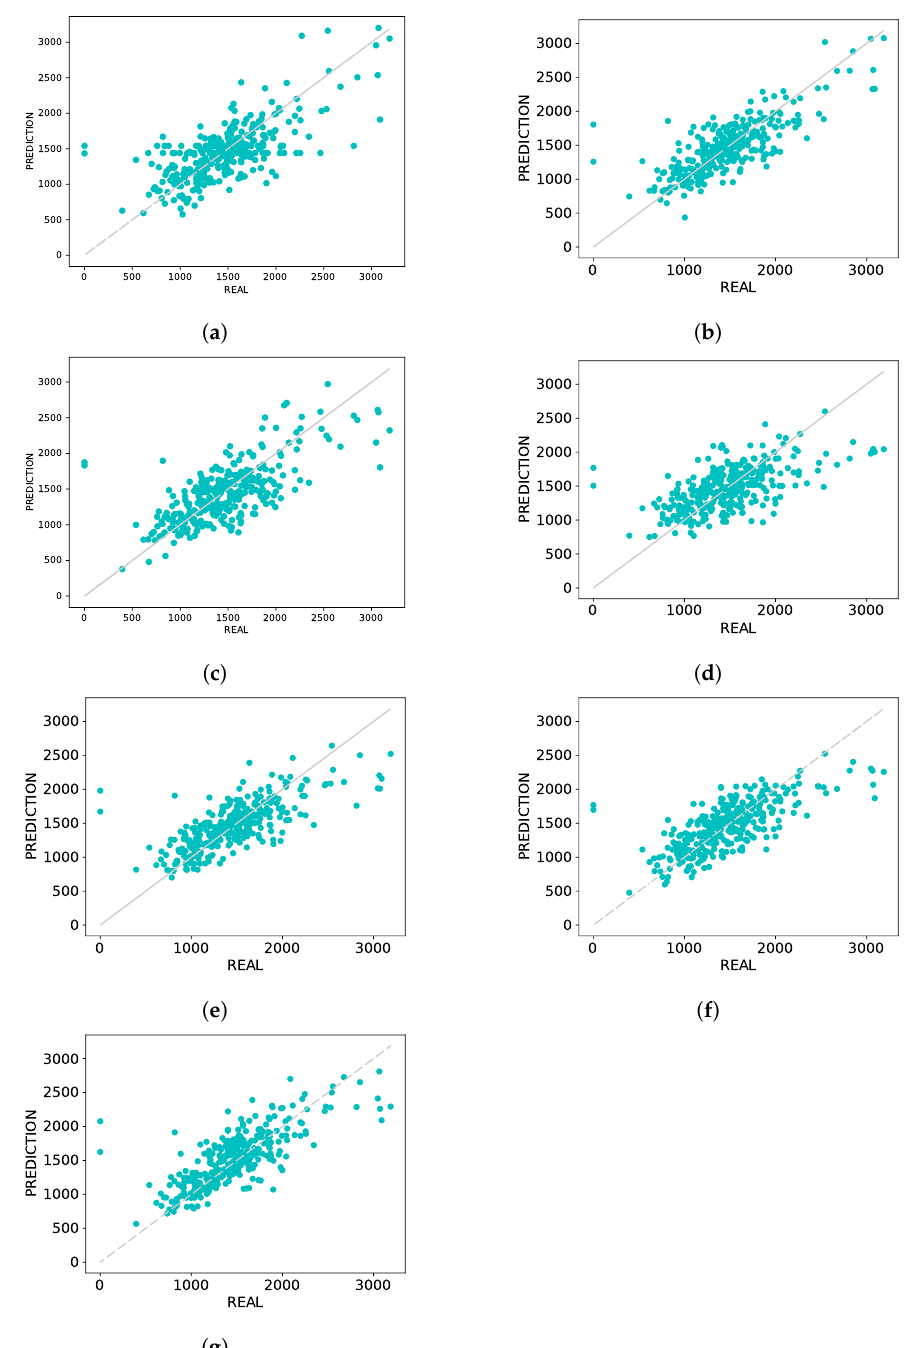
Figure 4. Predicted vs. Real plots-LDMY. ( a ) AlexNet; ( b ) AlexNet pretrained; ( c ) MaCNN; ( d ) LF- CNN; ( e ) ResNeXt50; ( f ) ResNeXt50 pretrained; ( g ) DarkNet53. Analyzing the graphs presented in Figure 4, which presents the plot of the estimated and real values of LDMY, it is possible to notice that for high values, above 2500 kg · ha − 1 , AlexNet pretrained (Figure 4b) provided smaller errors. The ResNeXt50 pretrained and DarkNet53 models presented more linear graphs (Figure 4f,g), providing less error mainly in the range of 1000 and 2000 kg · ha − 1 . The other networks (Figure 4a,c–e) have some major errors with respect to values between 1000 and 2000 kg · ha − 1 , and for higher values, they were able to estimate the values